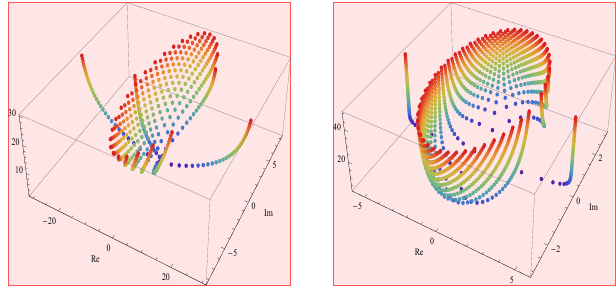
Figure 4. Stacking structure in 3D of C B n , q ( x ,5 ) for 2 ≤ n ≤ 30,0.5 ≤ q ≤ 0.9.